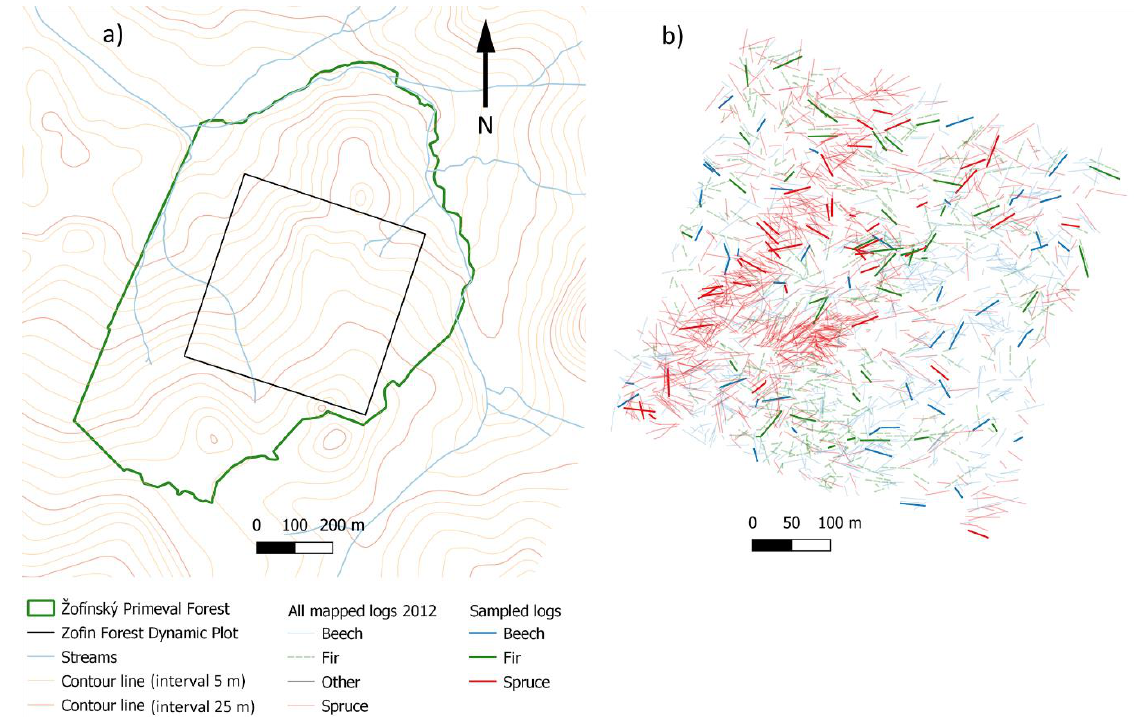
Figure 1. ( a ) Location of the Zofin Forest Dynamic Plot within the Žofínský Primeval Forest, contour lines from ČÚZK [36]; ( b ) Map of downed logs (mapped in 2012) and sampled logs according to tree species.